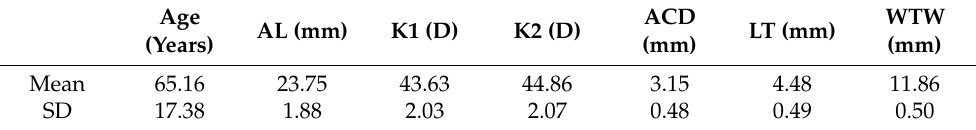
Table 1. Clinical characteristics.